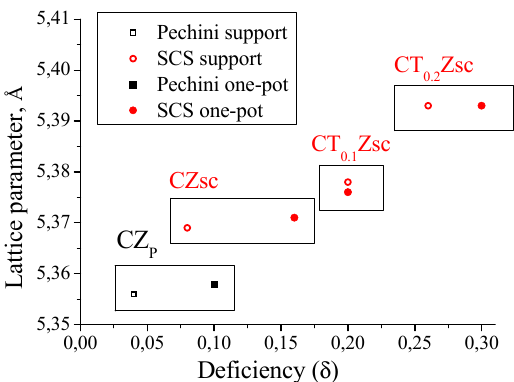
Figure 5. Dependence of the lattice parameter of initial supports and one-pot catalysts on the oxygen deficiency ( δ ).